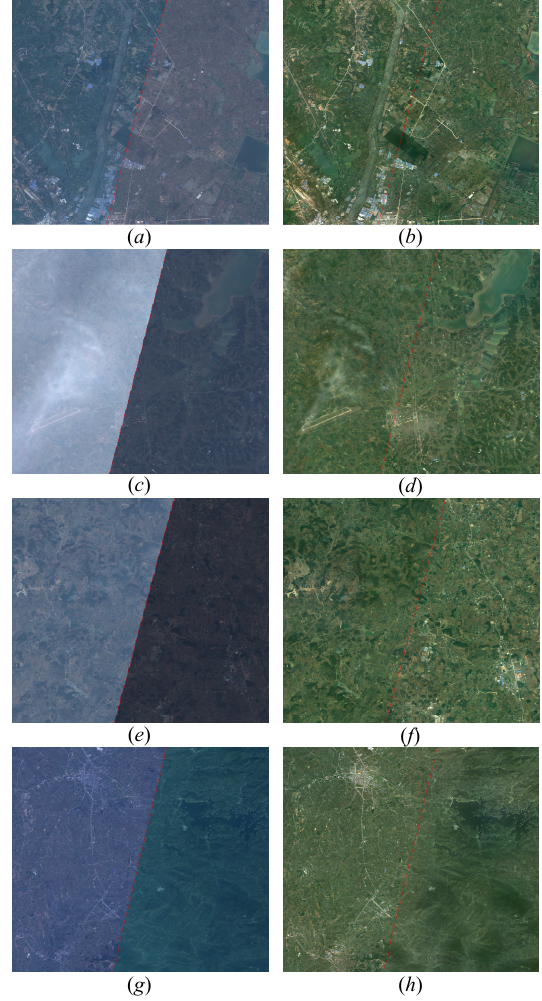
Figure 7. Mosaic results before and after color correction. From top to bottom are the color difference caused by season, atmosphere, illumination and sensor